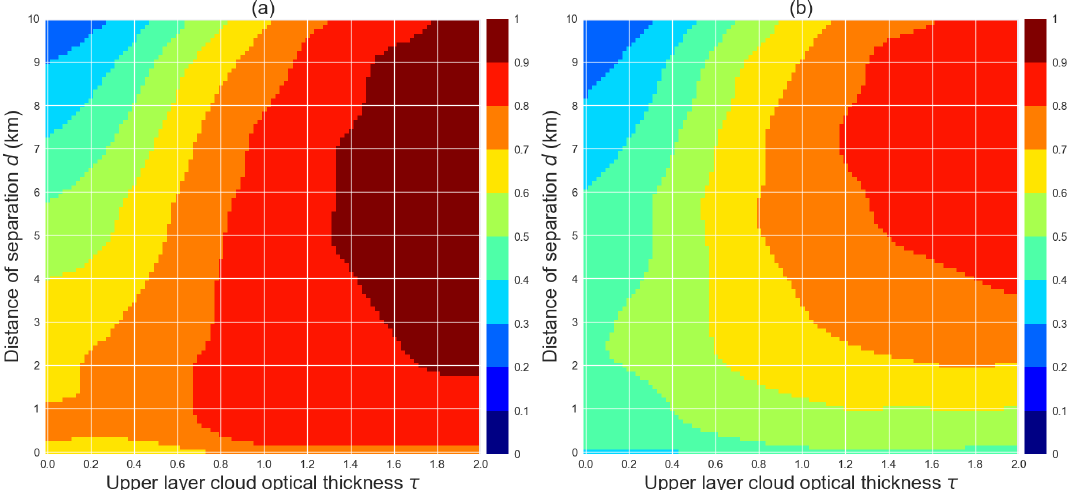
Figure 4. Probabilities that MYD06 detects a multilayer cloud, with (a) and without (b) the Pavolonis–Heidinger (PH04) test, given the separation distance between two cloud layers and the cloud optical thickness of the upper layer derived from 2B-CLDCLASS-lidar and CALIOP 5km cloud products, respectively.